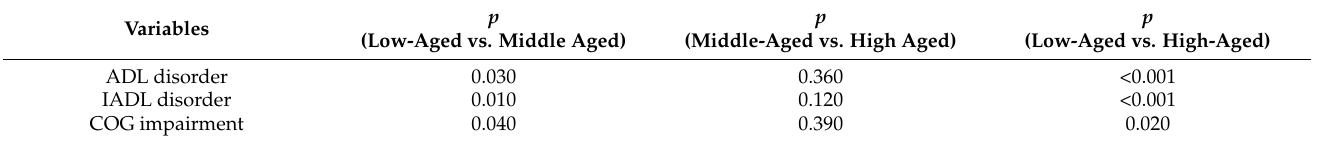
Table 8. Analysis of the difference of regression coefficient by